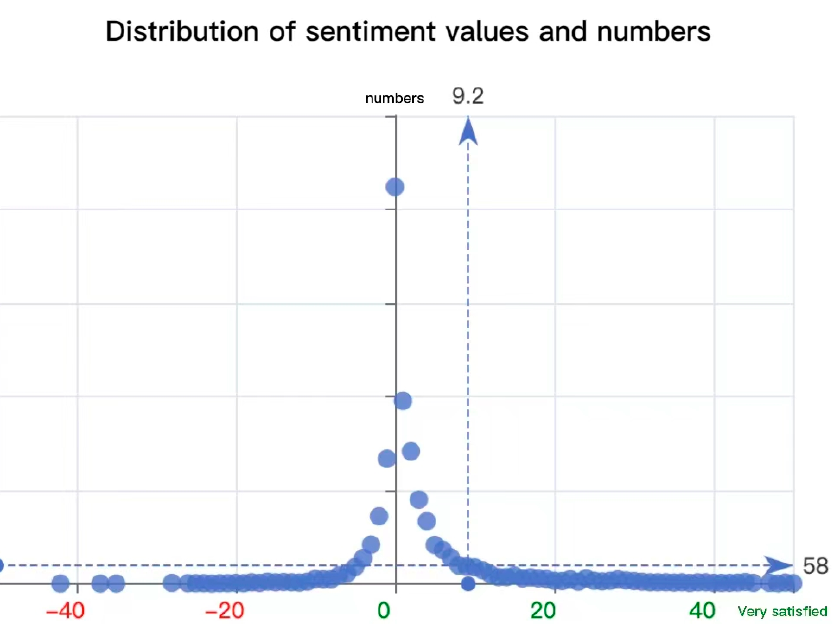
Figure 6. Sentiment distribution of the film reviews of Turning Red.